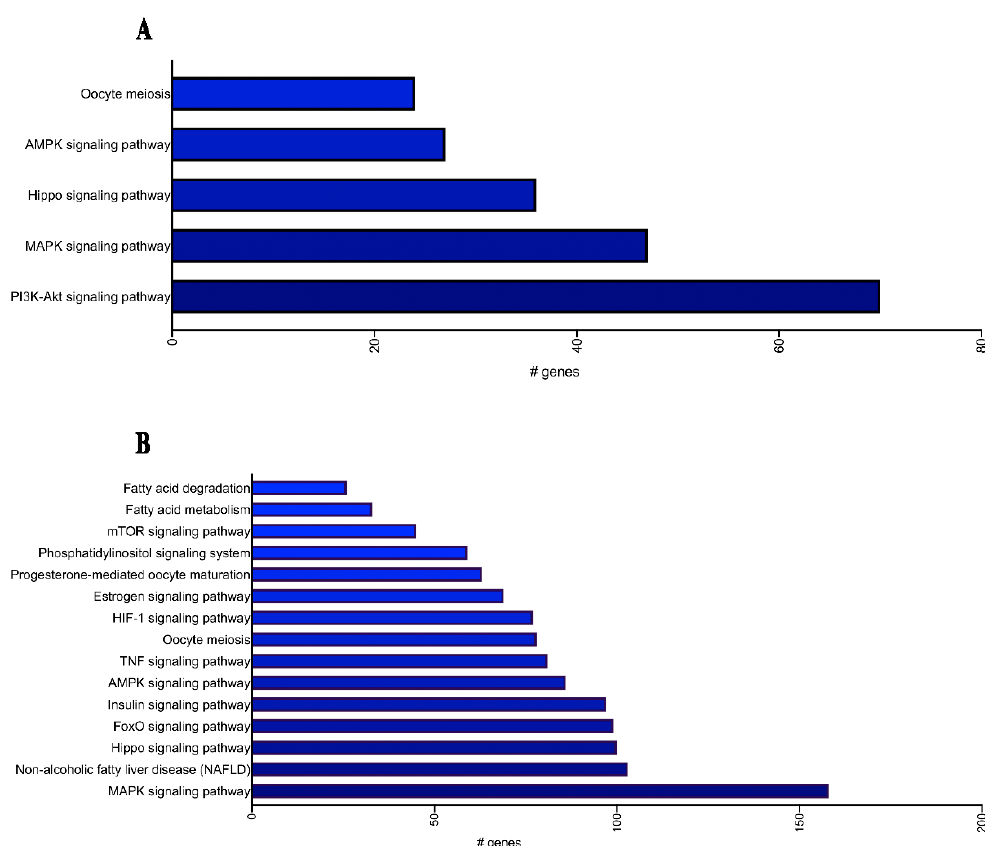
Figure 2. Enrichment analysis of differentially expressed (DE) miRNAs in GDM vs. NGT patients of the discovery cohort. Enrichment analysis of DE total plasma ( A ) and EVs-miRNAs ( B ) was performed with KEGG and demonstrates the involvement of a number of DE total plasma and EVs-miRNAs in GDM signaling pathways.